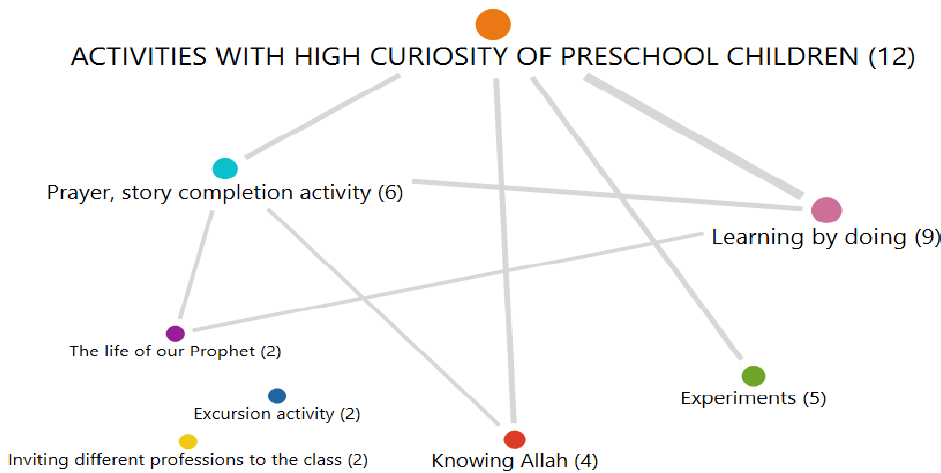
Figure 6. Activities in which the preschool children ’ s curiosity is high.